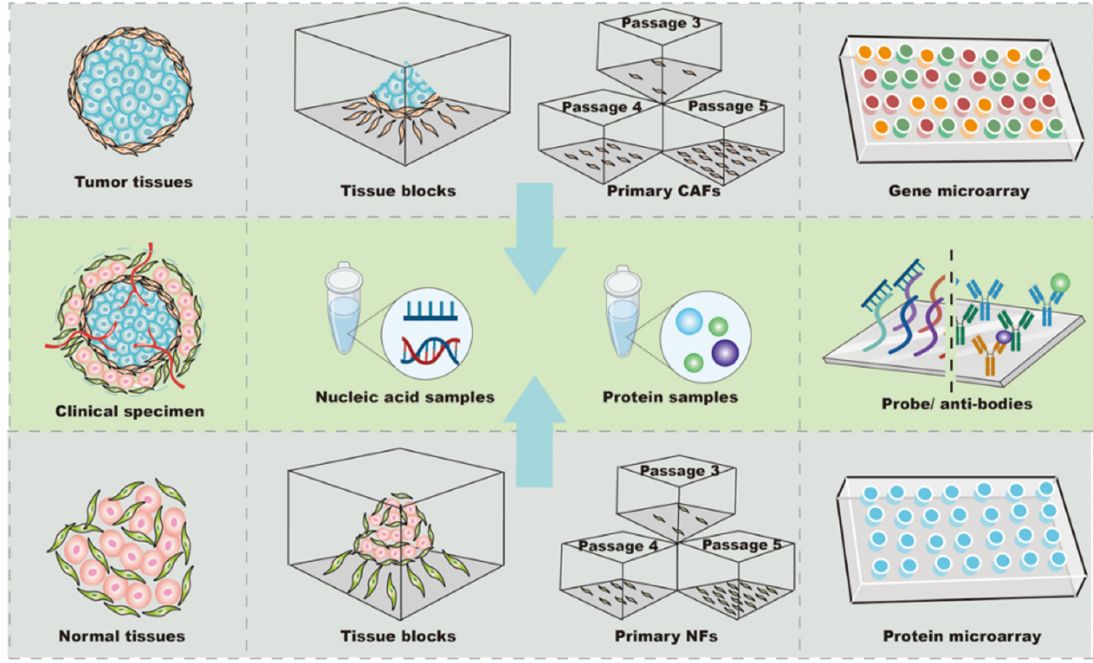
Figure 1. The biochips targeting CAFs in cancers. Tumor tissues and normal tissues are derived from clinical samples. Based on the difference in the adherence time of fibroblasts and tumor cells, CAFs or NFs are isolated and purified from tissue blocks for primary culture. Generally, the 3–5 passages cells are used for subsequent research, and nucleic acid samples or protein samples are extracted by commercial kits or centrifugation for subsequent testing. The large number of probes or antibodies fixed on the surface of the gene chip or protein chips specifically bind to nucleic acids or proteins in the sample to analyze differences in expression profiles.